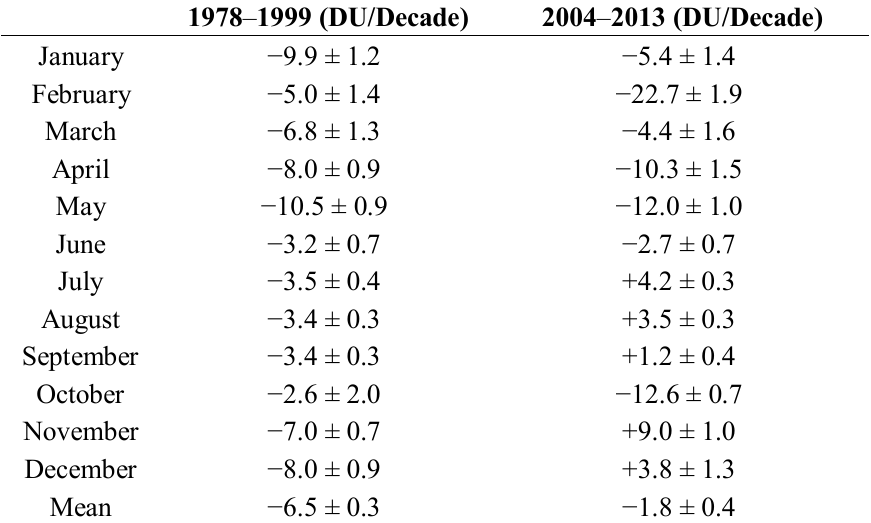
Table 3. Linear trends (±standard error) in DU per decade for each month over 33.5°N band and the two periods (1978–1999 and 2004–2013) in the Yangtze River